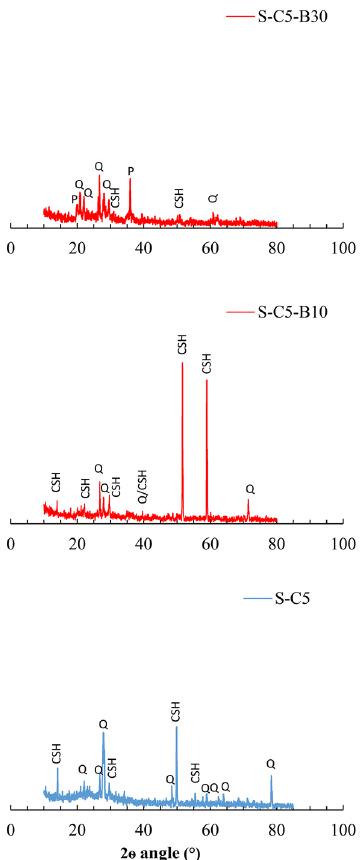
Fig. 23 The XRD graph of mixtures with 5% cement enriched with bentonite additive (Q: quartz, CSH: calcium silicate hydration, P: portandite, E: ettrinigite, K: